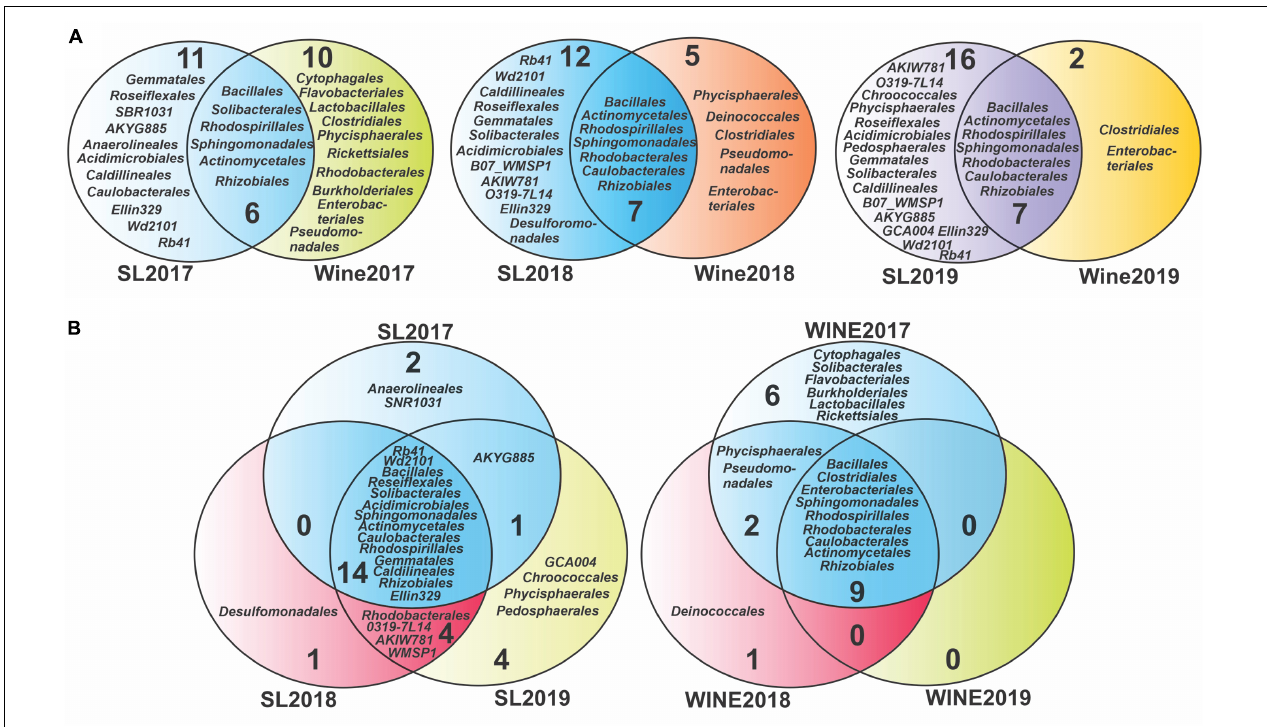
FIGURE 5 | Venn diagram analysis for the bacterial diversity of Saldungaray vineyard at the order level. Soil-wine diversity relation (A) , soil-related diversity, and wine-related diversity according to vintage year (B) .